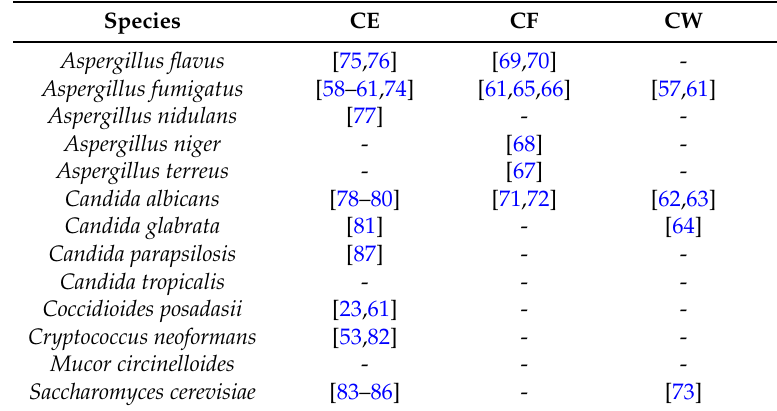
Table 4. Recently Published Fungal Proteomic Studies